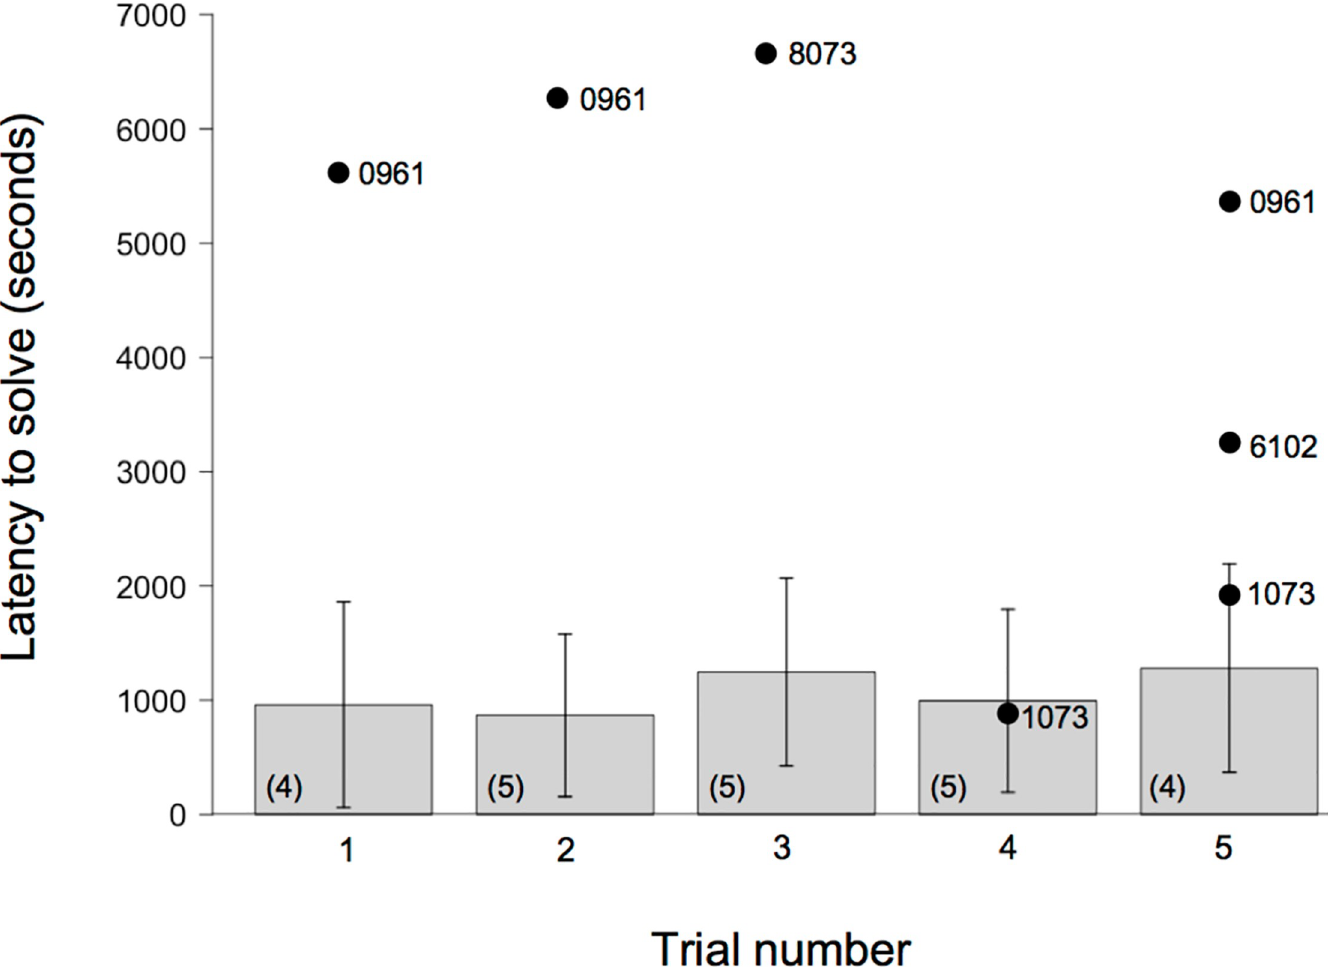
Fig 3. Latency to solve a puzzle box in study 1 for successful observer and control coyotes across all trials. Bar plots show mean ± SE for successful observer coyotes (number of observer coyotes that performed the task successfully on a given trial day is noted within parentheses directly in the bar plot). Sample sizes varied because not all coyotes were successful in every trial. Some control coyotes were also successful. Dots represent latency to solve the task for each successful control coyote in a given trial. ID of the successful control coyote appears directly beside the dot so that repeated successes by the same coyote are easily noted.